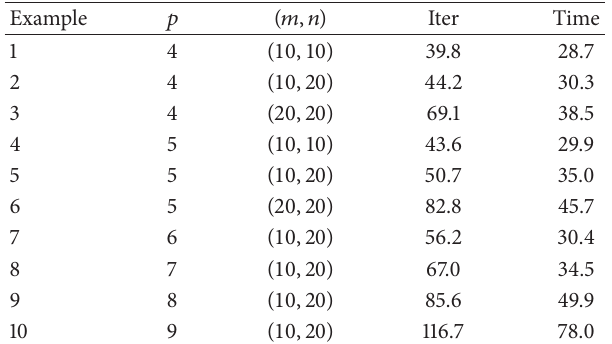
Table 1: Computational results of test